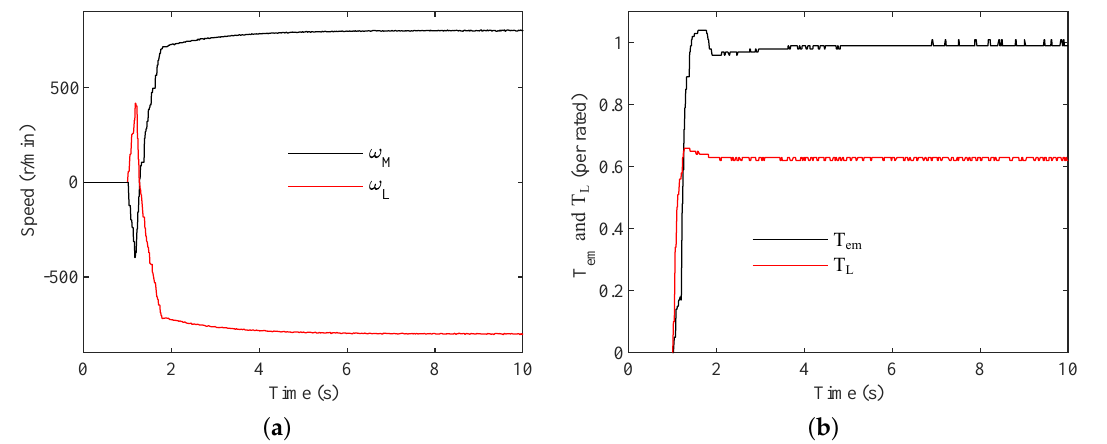
Figure 6. Experimental measurement while starting with 63% of the pull-out torque ( ω ref and T L are imposed at 1s, simultaneously): ( a ) speed of both side shafts; ( b ) T em and T L . The efficacy of pole-slipping detection and recovery strategies are now investigated.